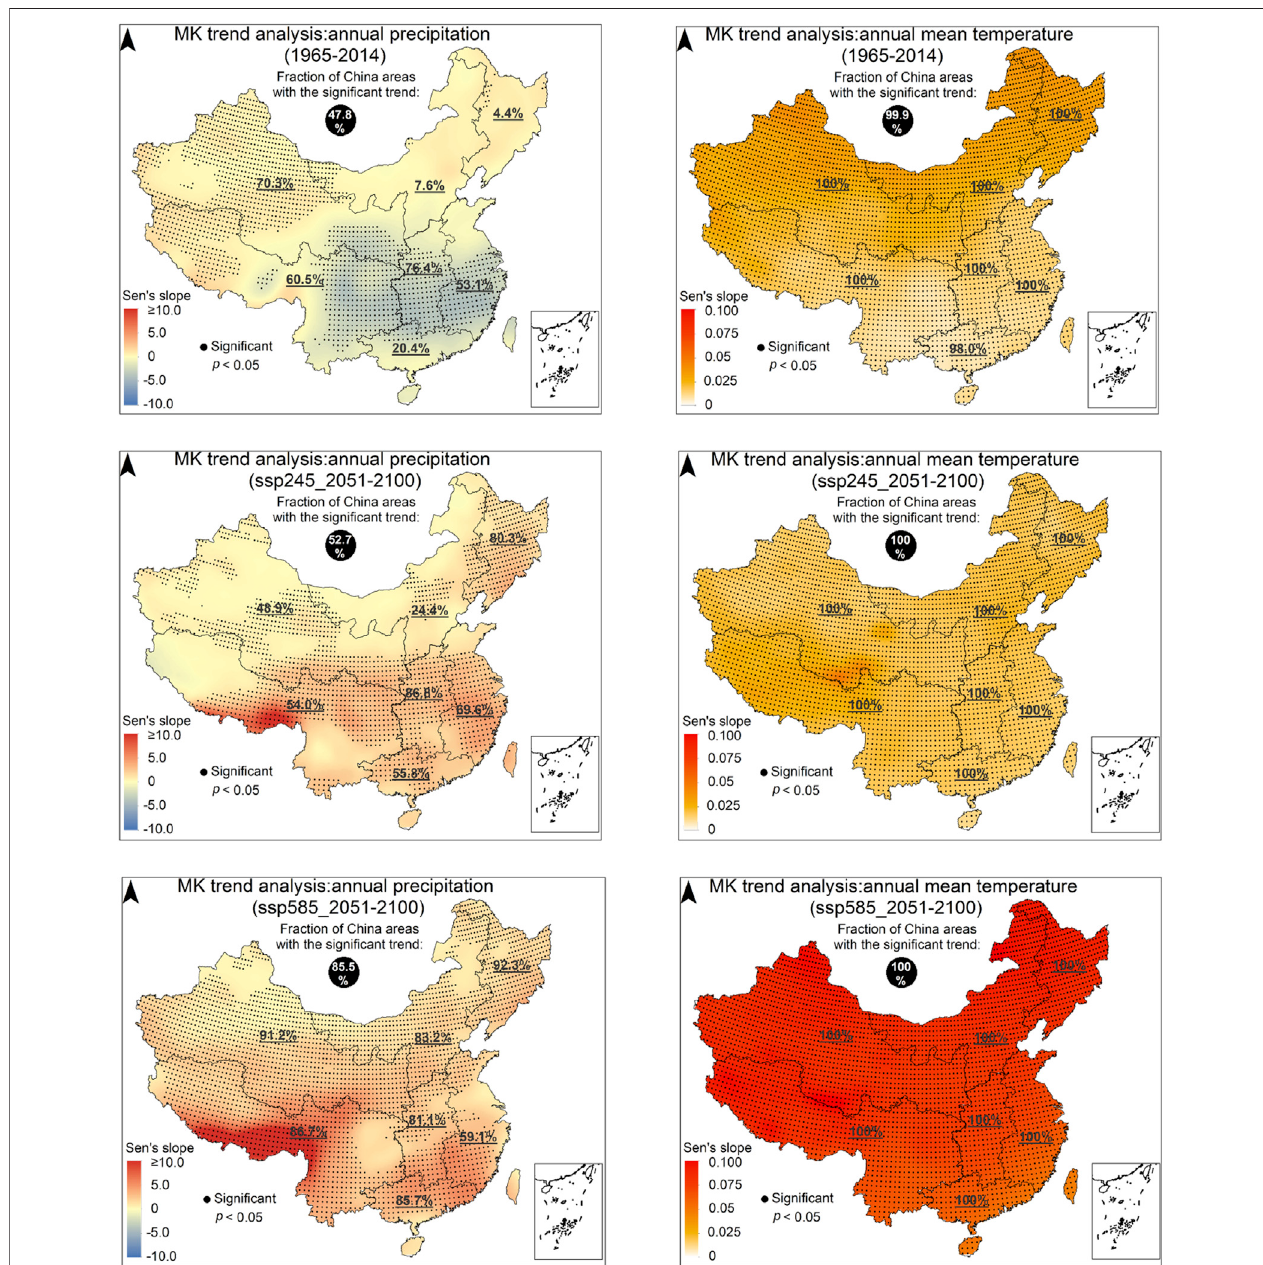
FIGURE3| TheresultsofMann-Kendall trendanalysisforannualprecipitation andannualmeantemperatureduringthehistoricalandfutureperiods.Thehistorical period is 1965 – 2014, and the future period is 2051 – 2100 under SSP245 and SSP585.